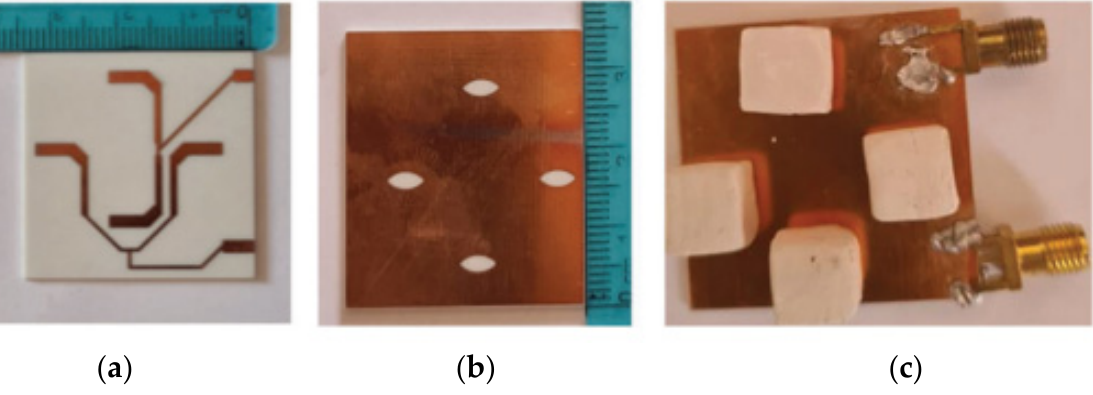
Figure 12. Fabricated RDRA array: ( a ) top plane; ( b ) bottom plane with eye slots; ( c ) bottom plane with dielectric resonators mounted over the eye slots [56].